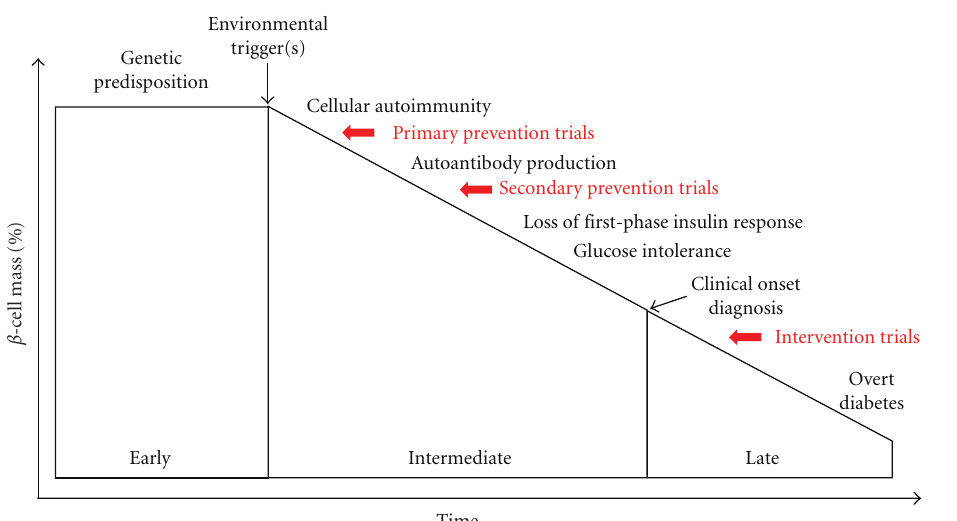
Figure 1: Stages of disease progression and intervention in T1D. Progression over time ( X -axis) from simple genetic susceptibility to β -cell autoimmunity and T1D is plotted against residual β -cell mass ( Y -axis). The time points at which immune therapies are administered are shown in